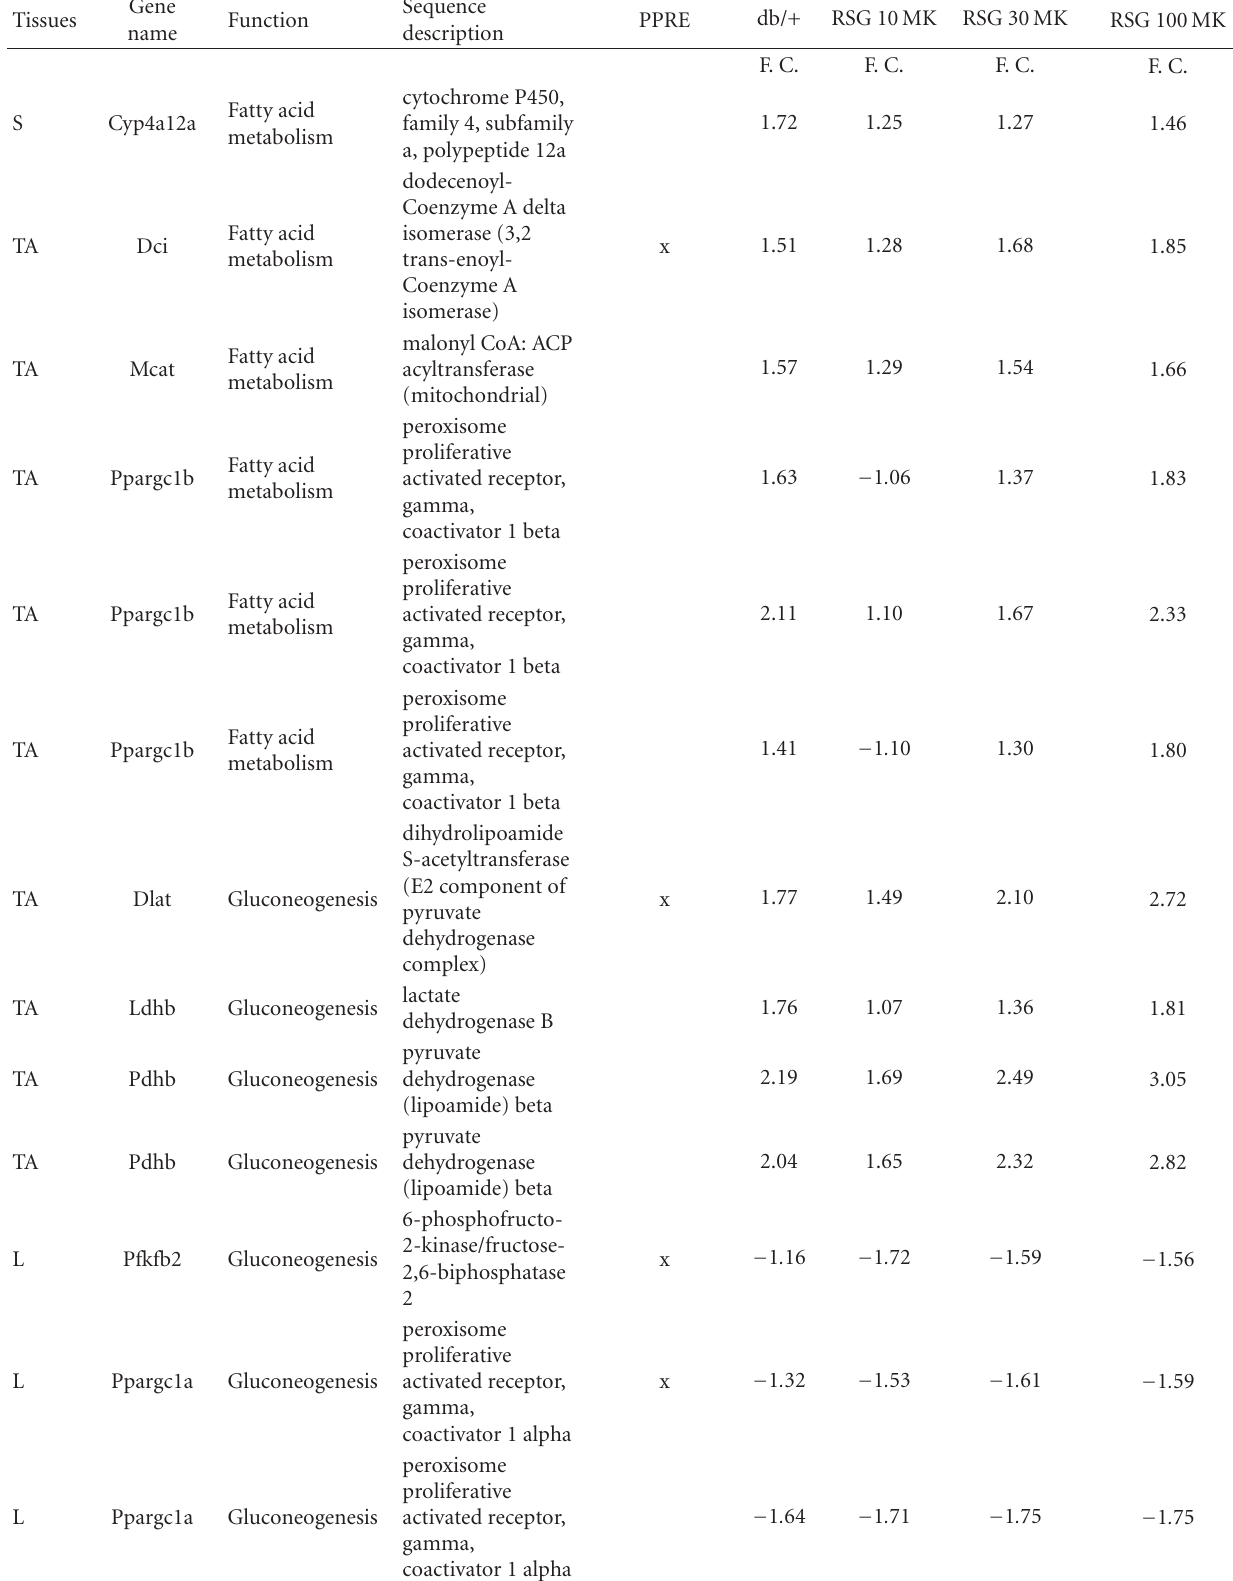
Table 3: Di ff erential expression of the 40 best predictor gene sequences from PLS analysis of combined tissues: liver, IAT, and soleus. x: MatInspector-predicted